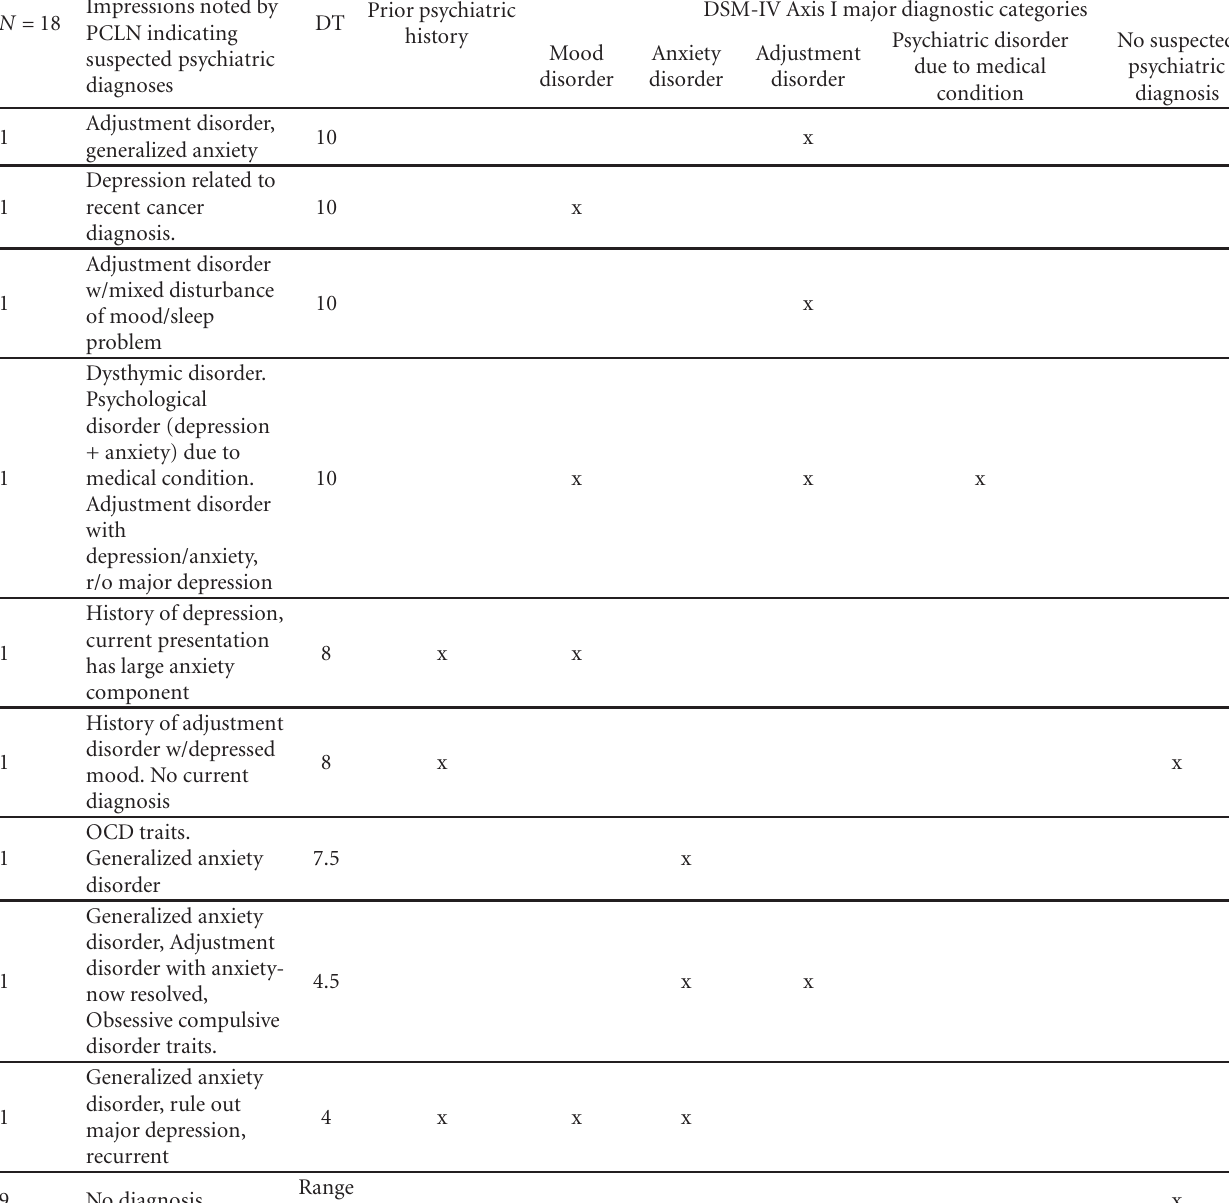
Table 3: Results of mental health evaluation by